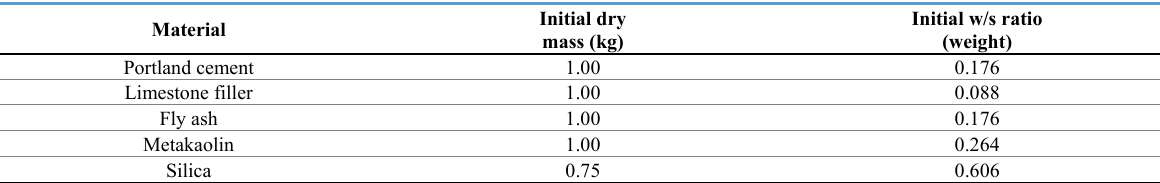
Table 5. Parameters used for each material when performing the mixing energy